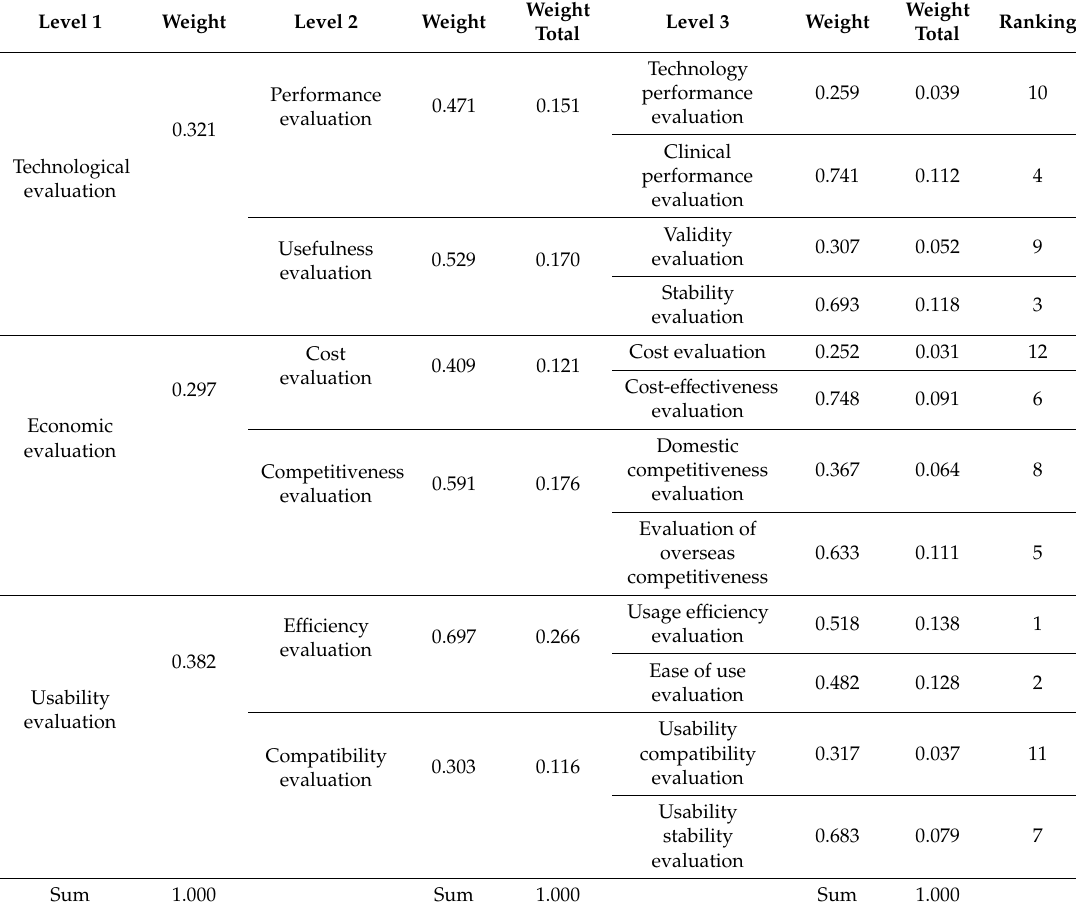
Table 5. Prioritization of the evaluation indices for selecting optimal medical